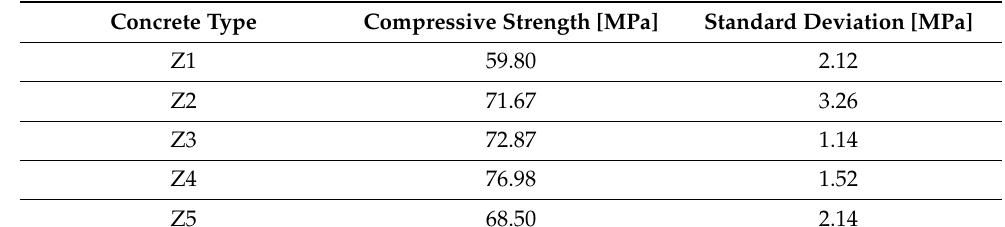
Table 7. Results of the compressive strength test.